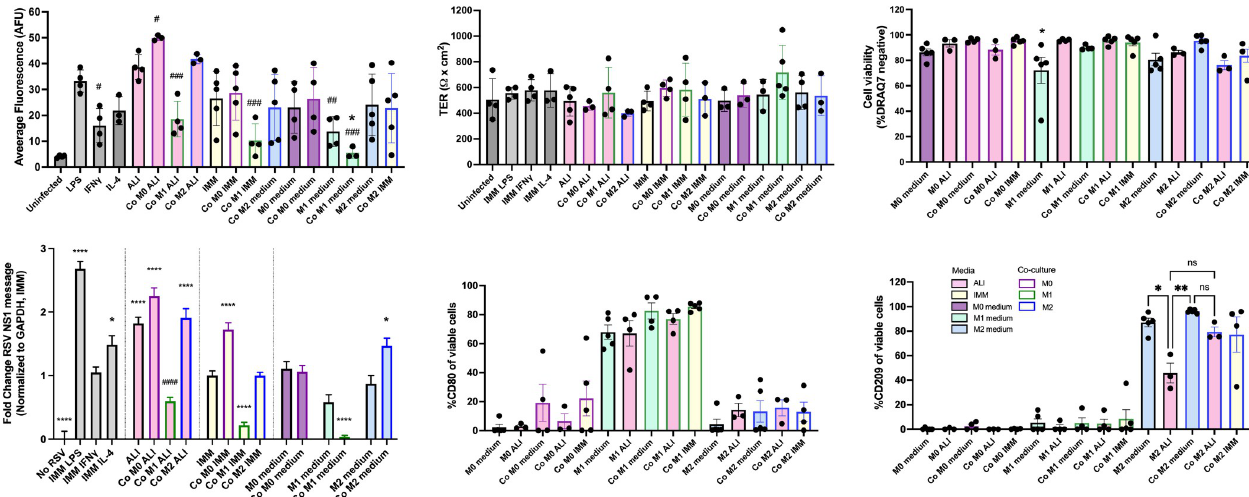
Fig 6. Co-culture with RSV infection. HBECs were placed in different media with or without co-culture with M0, M1, or M2 macrophages and infected with 0.15 MOI RSV. Cells were assessed 72 hours later for (A) Average fluorescence of images taken of epithelia, (B) Transepithelial electrical resistance (TER) of epithelia, (C) , Fold change in RSV NS1 by qPCR (GAPDH as housekeeping gene), (D) Macrophage viability as determined by flow cytometry and DRAQ7 ™ exclusion, or (E, F) Macrophage cell surface expression of CD80 or CD206 (M1 or M2 markers, respectively). In B and C, � p < 0.05, �� p < 0.01, ��� p < 0.001, ���� p < 0.0001 compared to IMM, or # p < 0.05, ## p < 0.01, ### p < 0.001, #### p < 0.0001 compared to ALI as assessed by ANOVA with Dunnett’s post hoc test, n = 3–5. In E and F, � p < 0.05, �� p < 0.01 as assessed by ANOVA with Tukey’s post hoc test between each macrophage group, n =